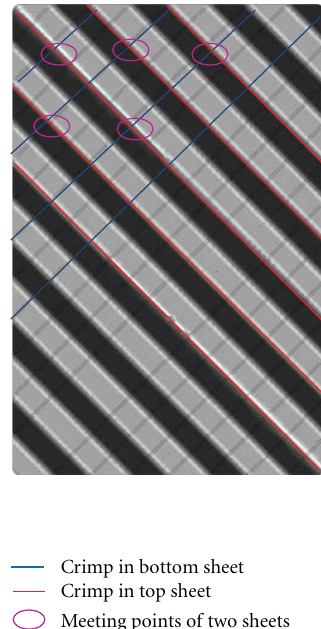
Figure 17: Explanation of meeting points from two corrugated sheets of packing and interest of our study.